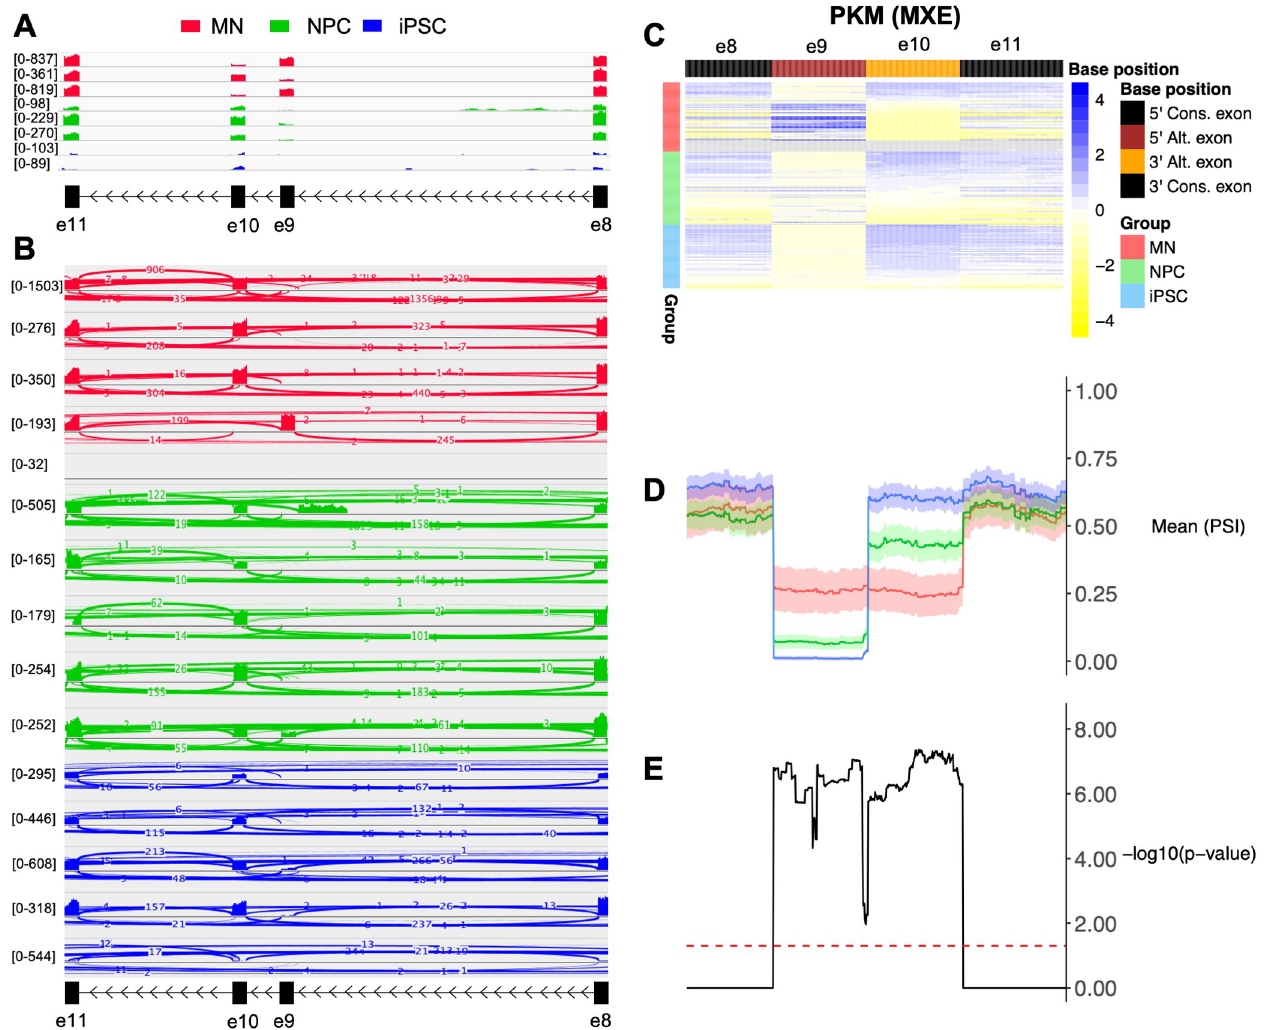
Fig 1. Read coverage and percent spliced-in (PSI) profile of PKM mutually exclusive exons 9 and 10 in single cells from 63 induced pluripotent stem cells (iPSCs), 69 motor neuron cells (MNs), and 73 neural progenitor cells (NPC) [8]. (A) Integrative Genome Browser (IGV) presentation of read coverage from bulk RNA-sequencing data. MNs showed different read coverage at exons 9 and 10 across replicates whereas NPCs and iPSCs showed consistently higher read coverage at exon 10 compared to exon 9 across all replicates. (B) IGV sashimi plot of selected single-cell RNA-sequencing data. Heterogeneity observed in relative read coverage at exons 9 and 10 across single cells with some single cells with low-to-no coverage. (C-E) VALERIE presentation of PSI values from entire single-cell RNA-sequencing data. (C) Heatmap unravelled 2 subpopulations of MNs and NPCs whereby one population exclusively expressed exon 9 while another subpopulation exclusively expressed exon 10, whereas iPSCs consist of a single homogenous population that exclusively expressed exon 10. (D) Mean PSI values across the genomic coordinates corresponding to the flanking constitutive exons and mutually exclusive exons. Overall, iPSCs showed decreased usage of exon 10 and increased usage of exon 9 after differentiating into MNs or NPCs. MNs showed similar usage of exons 9 and 10 whereas NPCs showed higher usage of exon 10 compared to exon 9. Shaded regions represent 95% confidence interval (CI) of the mean. (E) Differences in mean PSI values across iPSCs, MNs, and NPCs, were statistically significant at the genomic coordinates corresponding to alternative splicing event (mutually exclusive exons) but were, as expected, not statistically significant at the genomic coordinates corresponding to the flanking constitutive exons. P-values were computed using Kruskal-Wallis test and adjusted for multiple testing using Bonferroni correction. The red dashed line indicates -log10 of the p-value of 0.05. Colour bar indicates scaled PSI values (z-scores) across rows (single cells). Grey regions in the heatmap indicate genomic positions with less than 10x coverage. Alt. exon: Alternatively spliced exon. Cons. exon: Constitutive exon. MXE: Mutually exclusive